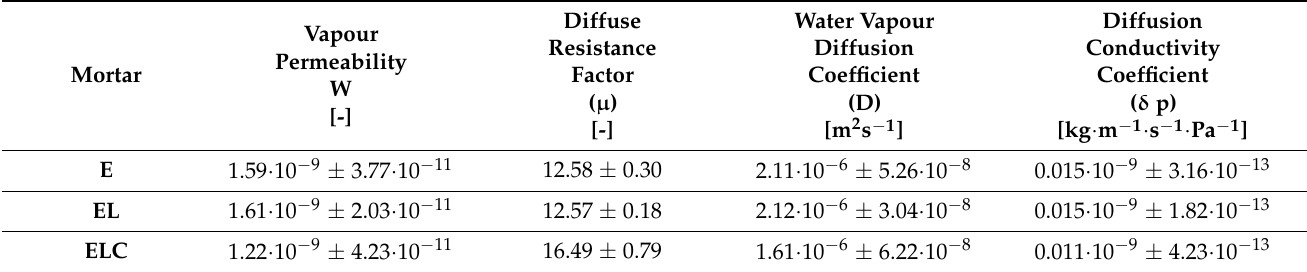
Table 4. Results of the vapour permeability test of hardened mortars.